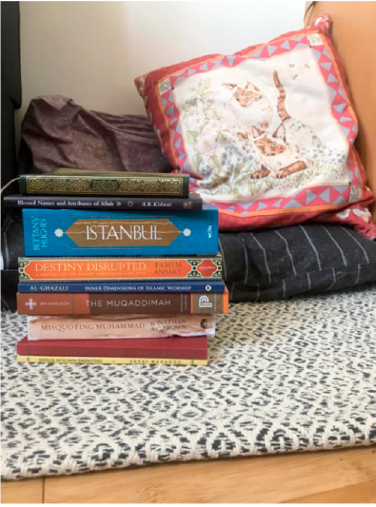
Figure 1. Ayah’s Ramadan corner (Ayah, Diary Image, Entry